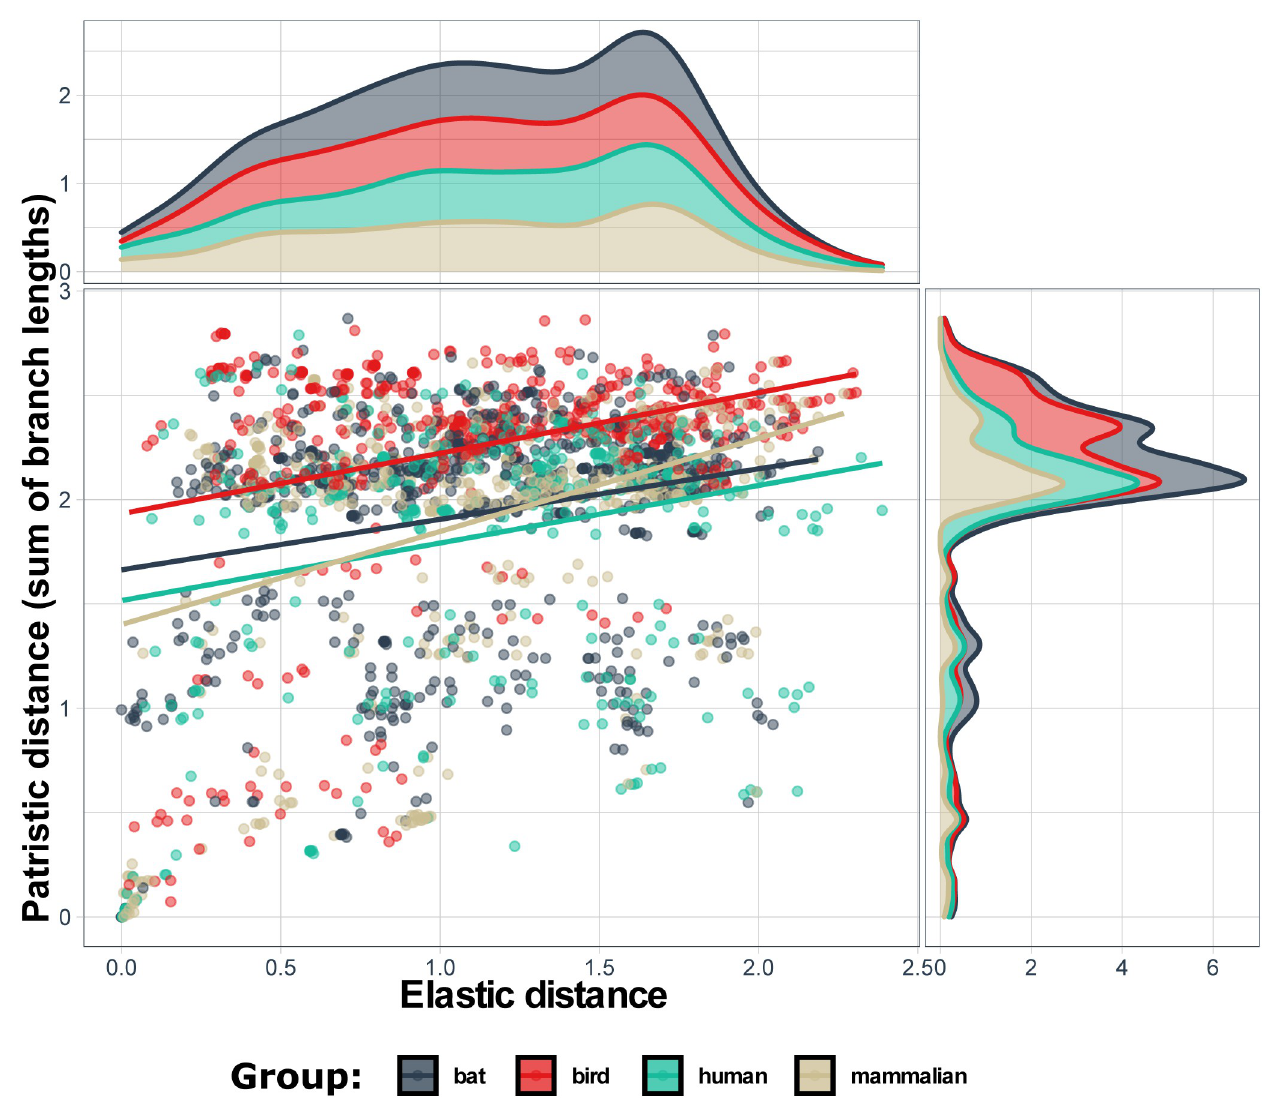
Fig 11. Relationship between pairwise elastic and patristic distances 1 (where the lengths of branches connecting the members of a pair are summed). Only the distances between genomes belonging to the same group according to the disease they cause are presented here. The distribution of the values of elastic distances is presented above the main graph and patristic distances on its right side. Regression lines are colored according to the six disease groups explained in the legend within graph.